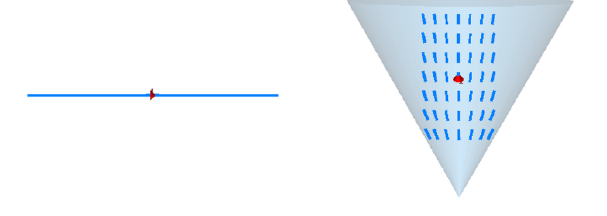
Fig. 7. Imaginary part (top panel), and real part (bottom panel) of Fig. 4.Straight dipole and array of 7x7 straight elements (the Z A of the isolated curved wire (blue line) and the wire surrounded central one is fed) by identical passive ones (green